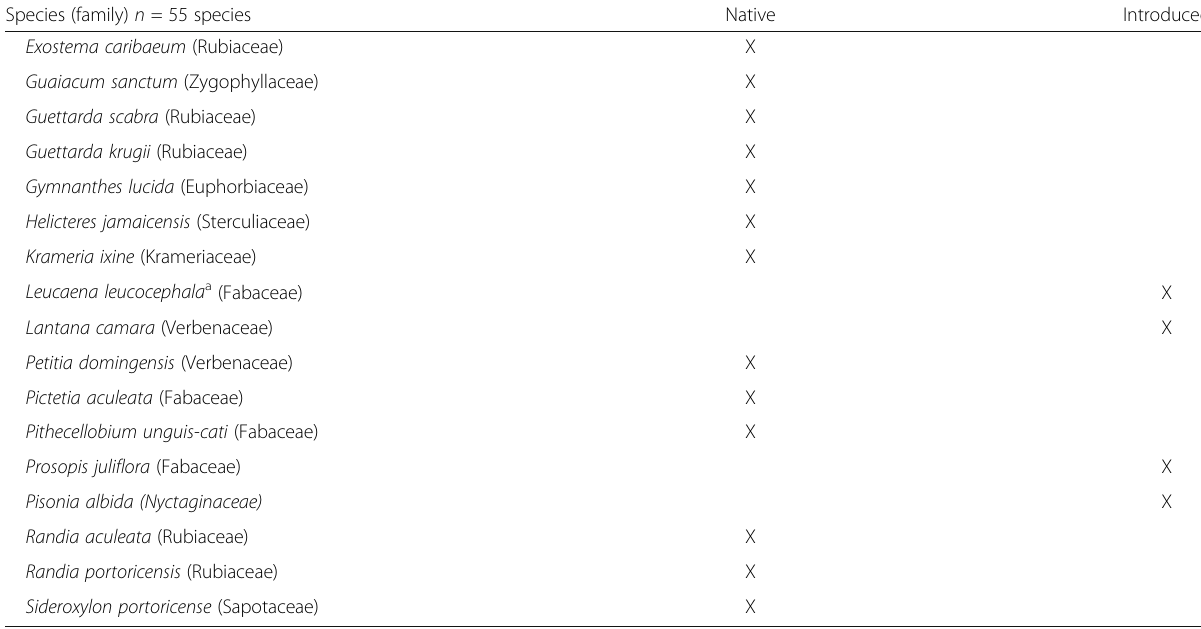
Table 2 Plant species and species origin grouped by growth habit recorded in vegetation surveys of the 38 transverse transects along the 570-m-long bulldozer trail from July 2012 to July 2013 in the Ensenada sector of Guánica Forest, Puerto Rico (Continued) Species (family) n = 55